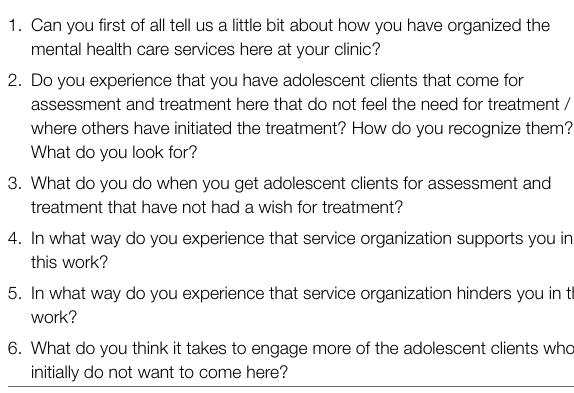
TABLE 1 | Interview guide for the focus group interviews with established treatment